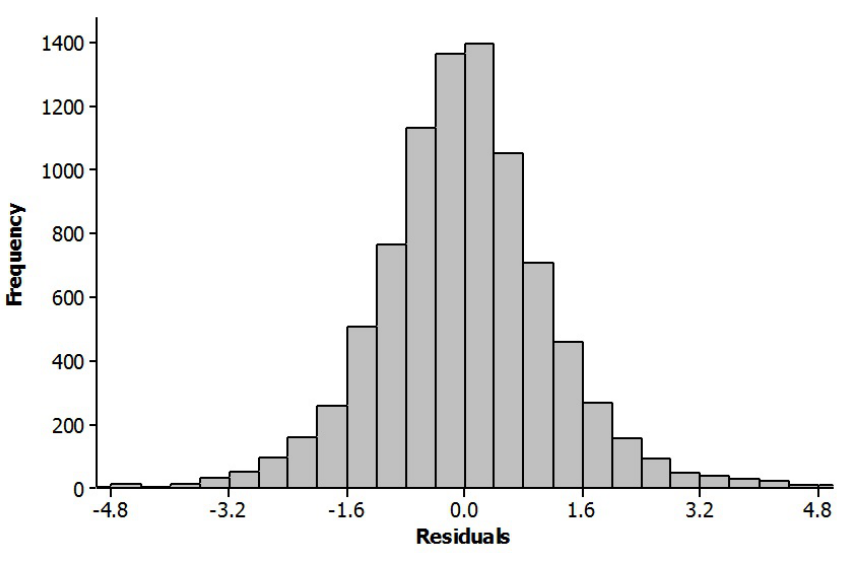
Figure 9. Error histogram for the ARIMA model in La Mata.